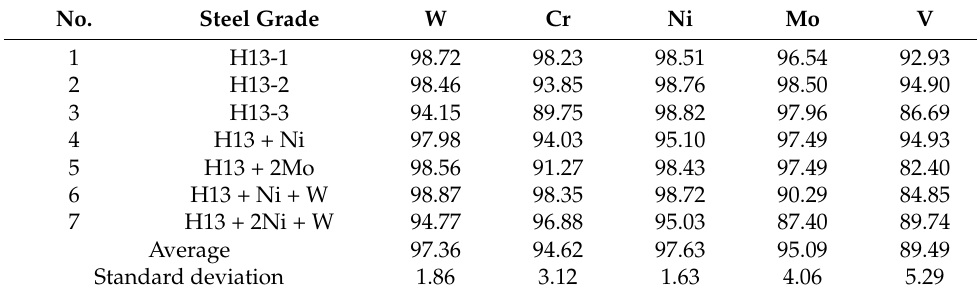
Table 3. Recovery percentages of alloying elements in smelting process